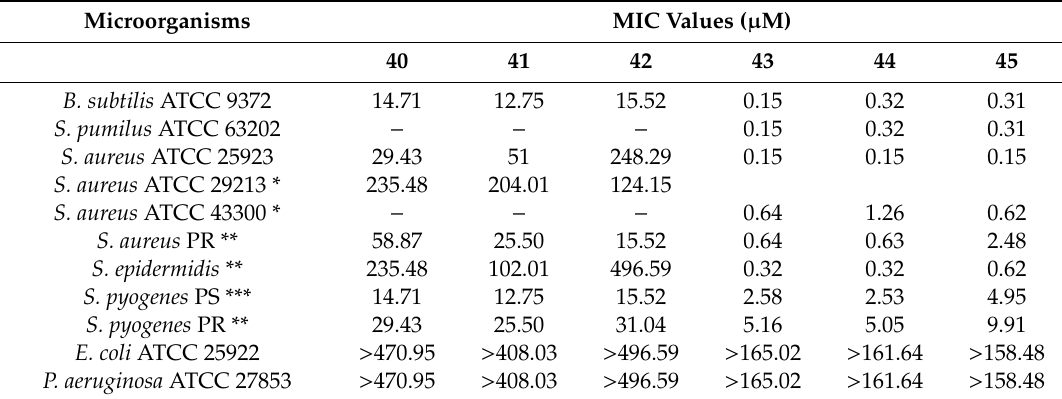
Figure 8. Chemical structures of the phenanthridium derivatives. Table 6. MIC values of the phenanthridium analogues.